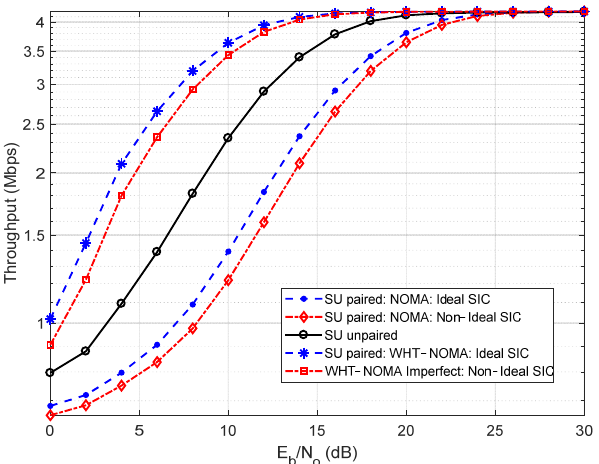
Figure 12. Throughput performance using QAM modulation; NOMA vs. WHT–NOMA, power allocation: SU (SCU) = 0.4 and MU (SEU) = 0.6.